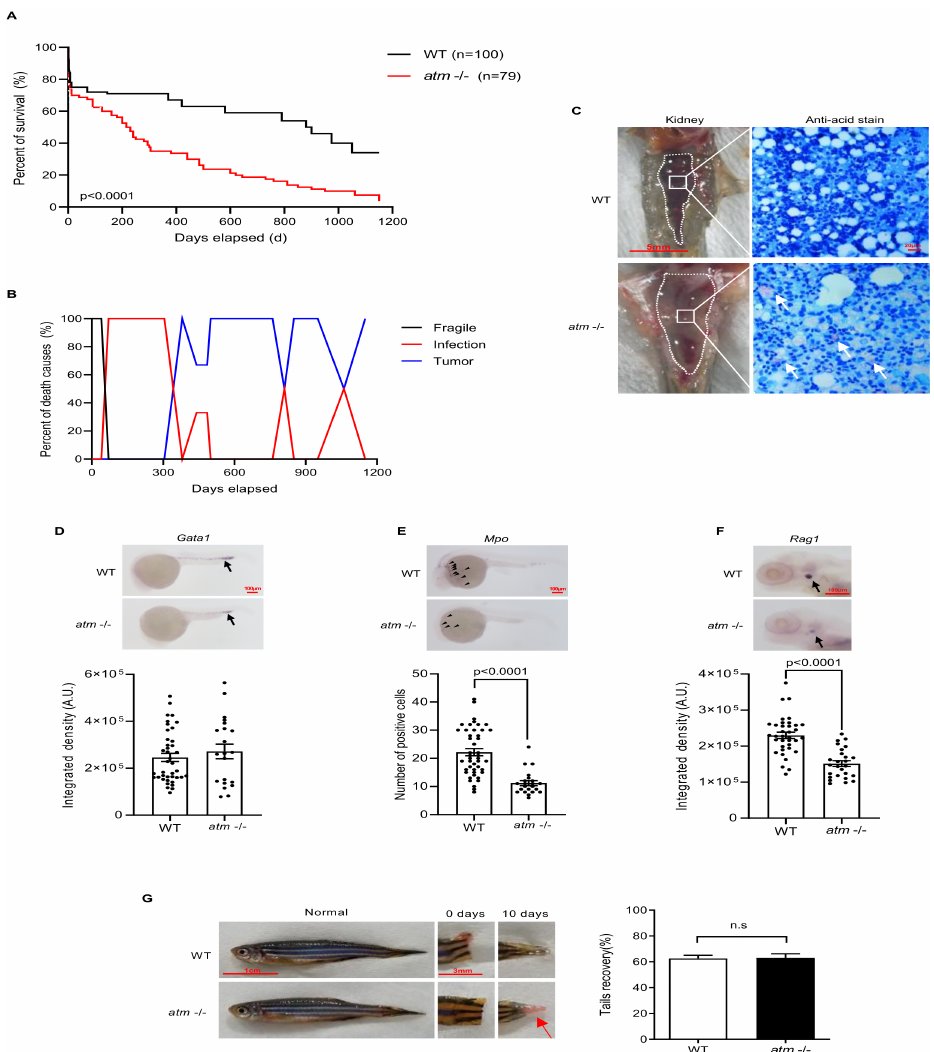
Figure 3. Loss of atm in zebrafish causing premature death, immunol deficiency, and regeneration abnormality. ( A ) Life span of WT and atm − / − zebrafish. ( B ) Causes of death in WT and atm − / − zebrafish. ( C ) Kidney marrow anatomy and anti-acid staining of infective tissue. ( D – F ) Whole- embryo in situ hybridization on atm − / − and WT zebrafish. ( D ) Representative images of gata1 expression (black arrows) in WT and atm − / − embryos at 24-hpf (top). Quantification of the gata1 signal (bottom) (n = 40 for WT; n = 21 for atm − / − ). ( E ) Representative images of mpo expression (black arrow) in WT and atm − / − embryos at 24-hpf (top). Quantification of the mpo signals (bottom) (n = 45 for WT; n = 22 for atm − / − ). ( F ) Representative images of rag1 expression (black arrow) in WT and atm − / − embryos at 5-dpf (top). Quantification of the rag1 signal (bottom) (n = 36 for WT; n = 26 for atm − / − ). ( G ) General observation of regeneration ability of atm − / − zebrafish’s caudal fin amputation. Ratio of tail recovery is quantified (n = 12 for each group). The statistical significance is analyzed using the two-tailed Student’s t-test. Data are shown in means ±